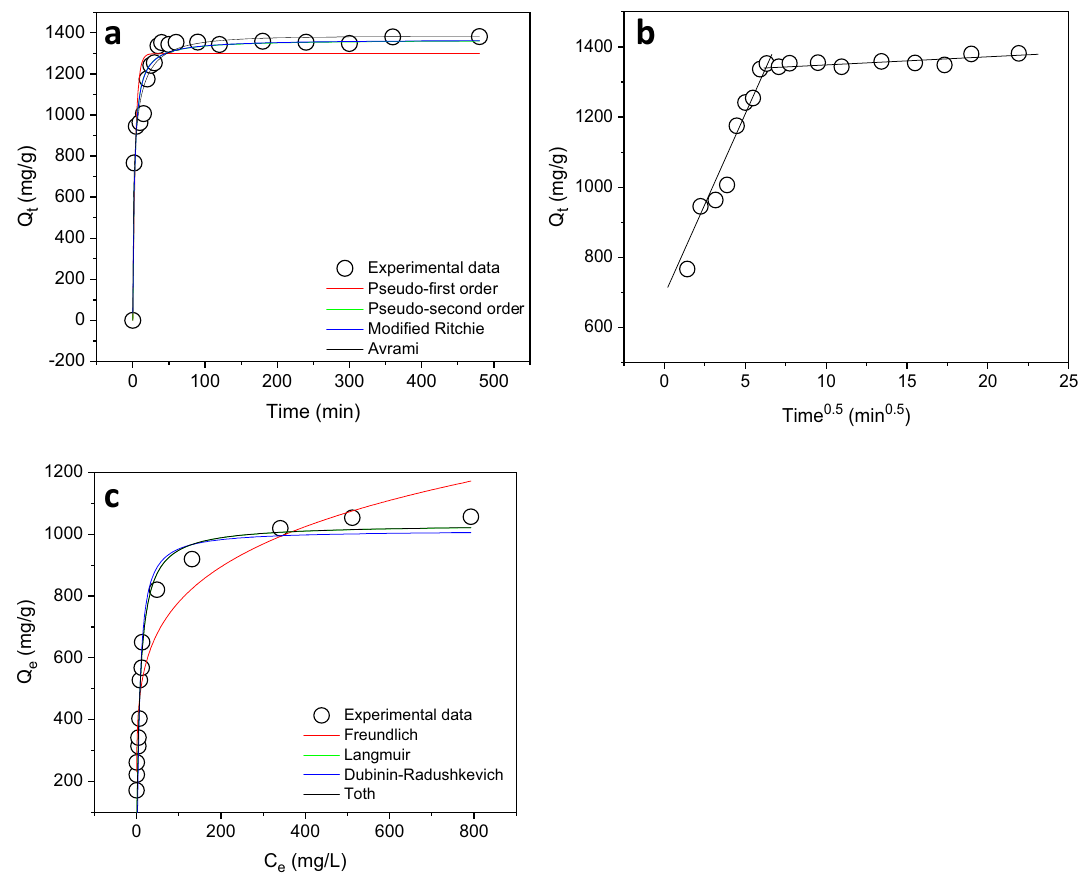
Figure 2. The curves of ( a and b ) kinetic modelling and ( c ) equilibrium modelling of data. Conditions: initial pH of the solution = 2; mass of adsorbent = 0.05 mg; temperature = 25 °C; agitation time = 0–480 min (kinetic study) and 1 h (equilibrium study); initial concentration of Congo red = 2 g L –1 (kinetic study) and 0.02–3 g L –1 (equilibrium study); volume of Congo red = 20 mL; and agitation speed = 160